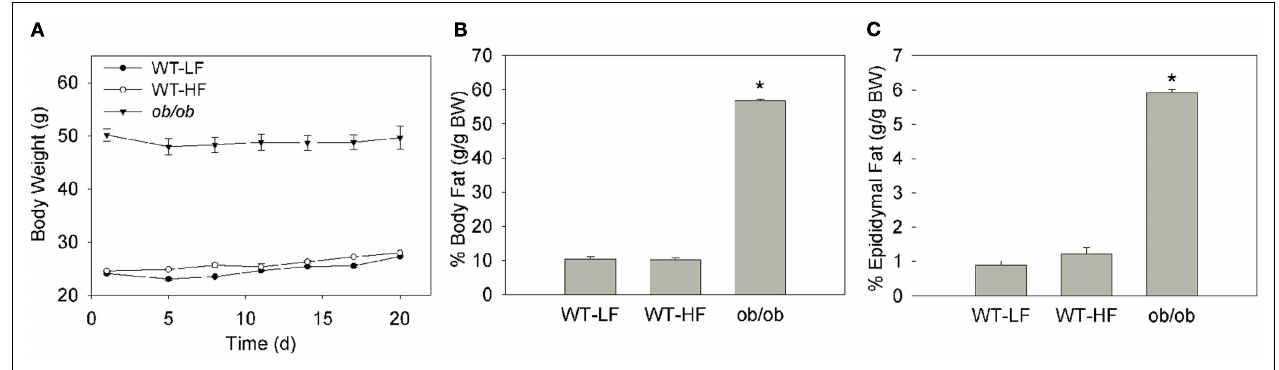
Percent of total body weight as epididymal fat determined by tissue weight. Data represent average ± SEM, p < 0.05 or lower versusWT–LF, n = 5–6 for WT, n = 3 for ob/ob